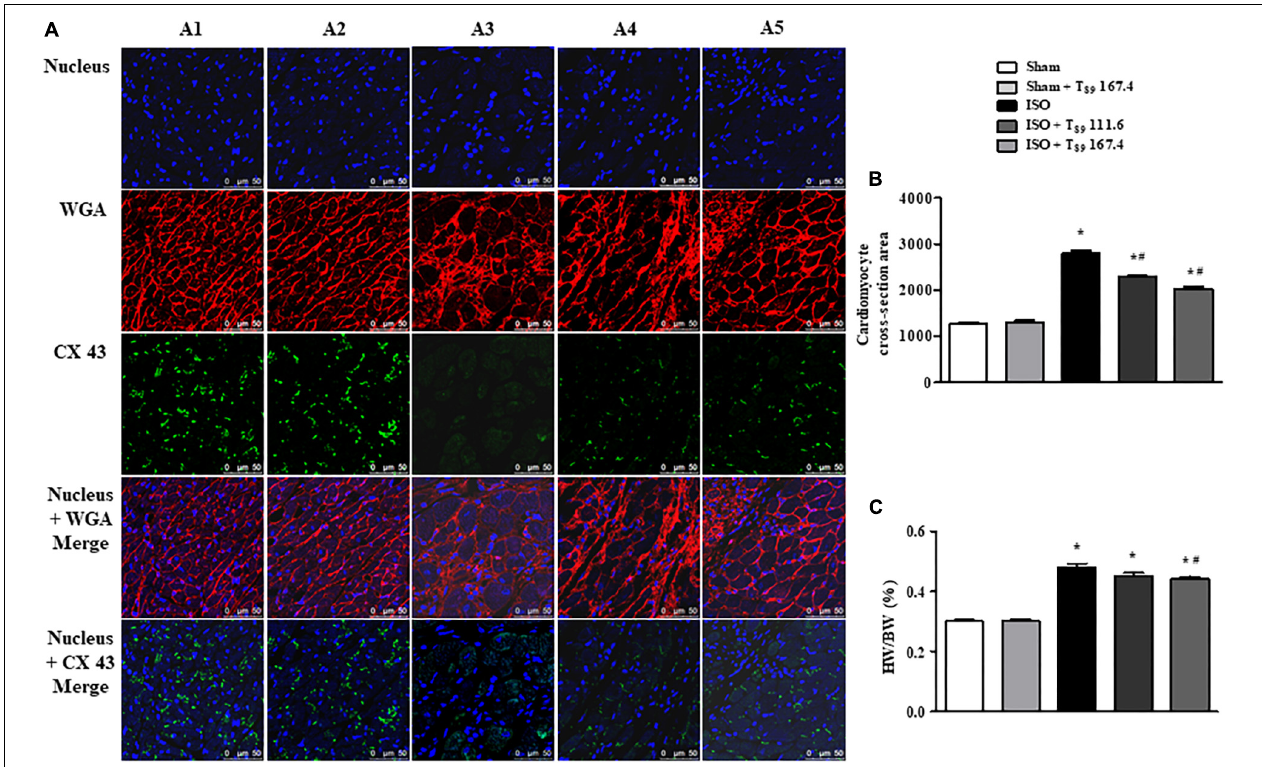
FIGURE 7 | Effect of T 89 on ISO-induced cardiac hypertrophy. (A) Representative images of immunofluorescent staining of WGA and CX 43 in Sham (A1), Sham + T 89 167.4 group (A2), ISO (A3), ISO + T 89 111.6 (A4), and ISO + T 89 167.4 (A5) groups. WGA is stained red, CX 43 is stained green, and nucleus blue. Bar = 50 µ m. (B) Quantitative analysis of cardiomyocyte cross-section area. n = 4. (C) The ratio of HW/BW in each group. n = 11. * P < 0.05 vs. Sham group, # P < 0.05 vs. ISO